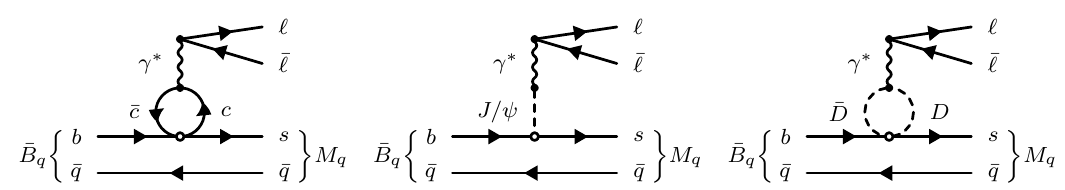
Figure 1 . Sketch of the pollution of b → s‘‘ processes by hadronic intermediate states. Here ¯ M q = K ( ∗ ) , φ, . . . denotes a meson with quark content ¯ qs . On the left we show the partonic representation; in the middle and on the right we show possible hadronisations of the partonic picture. The unfilled circle represents an insertion of an (¯ sc )(¯ cb ) WET